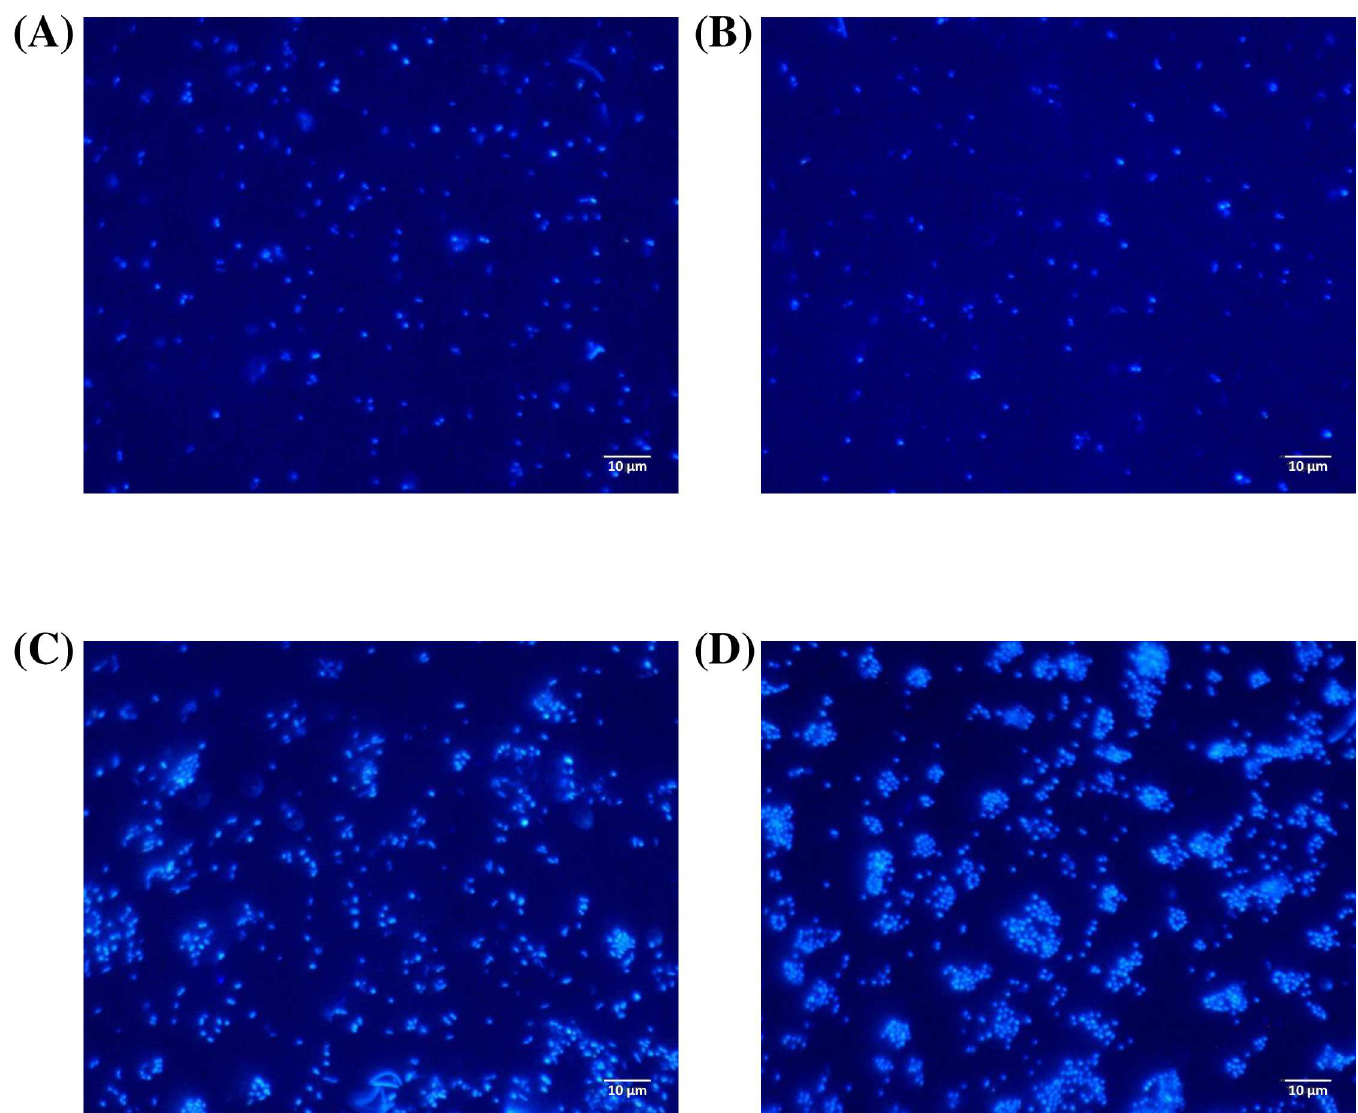
Fig 1. Epifluorescence microscopic pictures acquired during Phase 2, Shear 1 and Shear 2 experiments. Different wall shear stresses were tested: 0.09 Pa (A), 0.79 Pa (B), 3.7 Pa (C) and 7.3 Pa (D). Pictures were obtained with a 60x water immersion